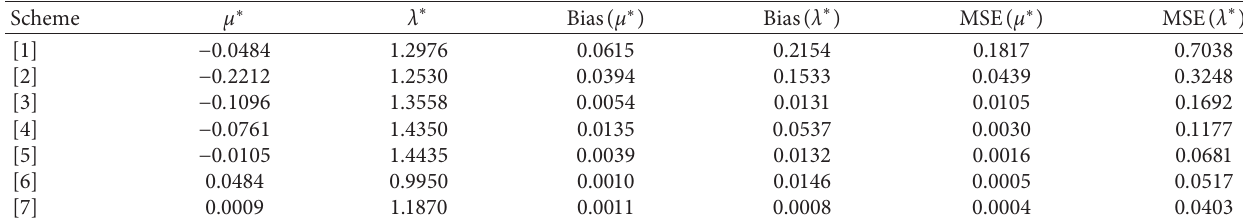
Table 5: ABLUEs μ ∗ , λ ∗ , biases, and MSEs for μ and λ from APE distribution when α � 3 . 5. Scheme